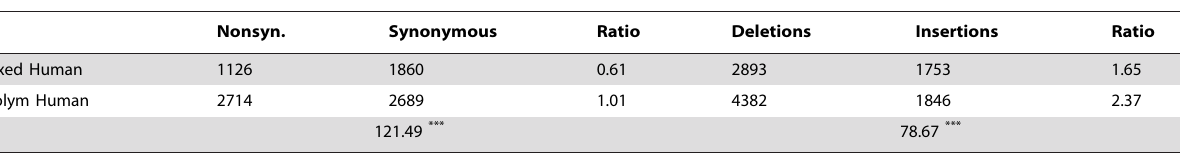
Table 4. McDonald-Kreitman